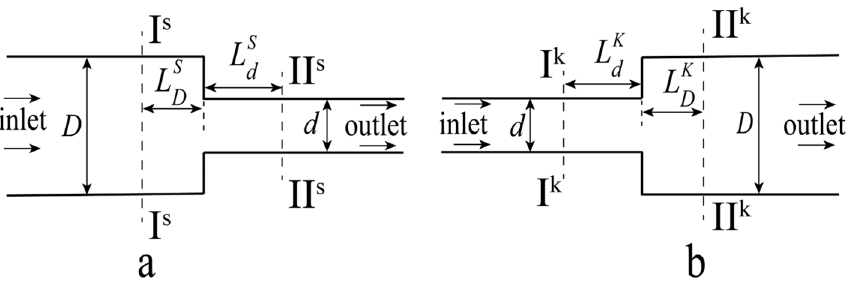
Figure 3. Schematic diagram of the pipe structure with a reduced or increased diameter. ( a ) reduced structure; ( b ) increased structure.